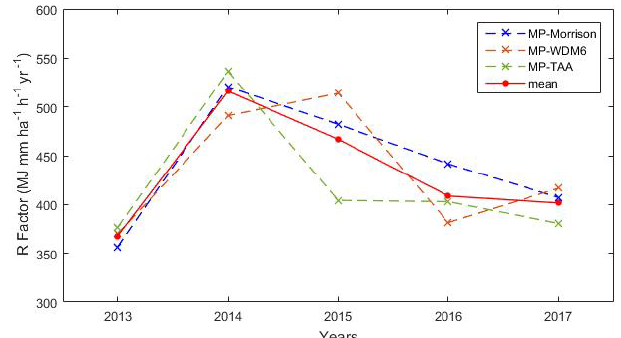
Figure 11. WRF-derived average annual rainfall erosivity of all the WRF grids covering the whole UK